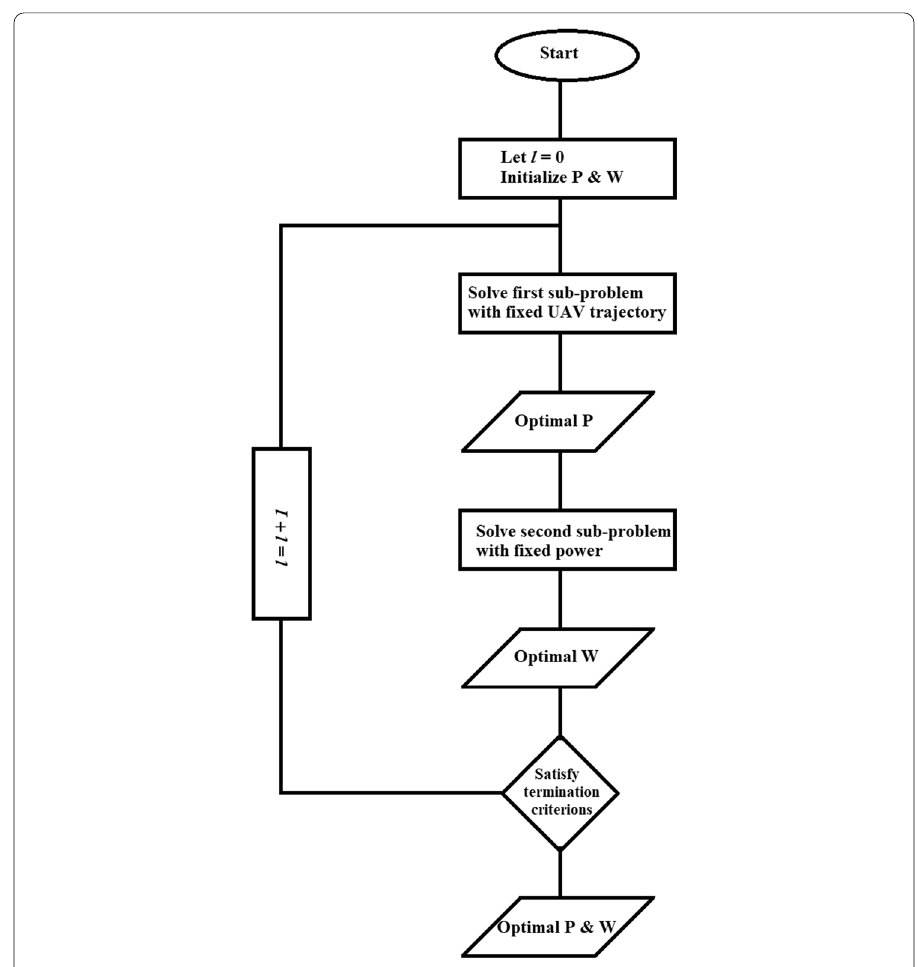
Fig. 2 Flowchart of the proposed